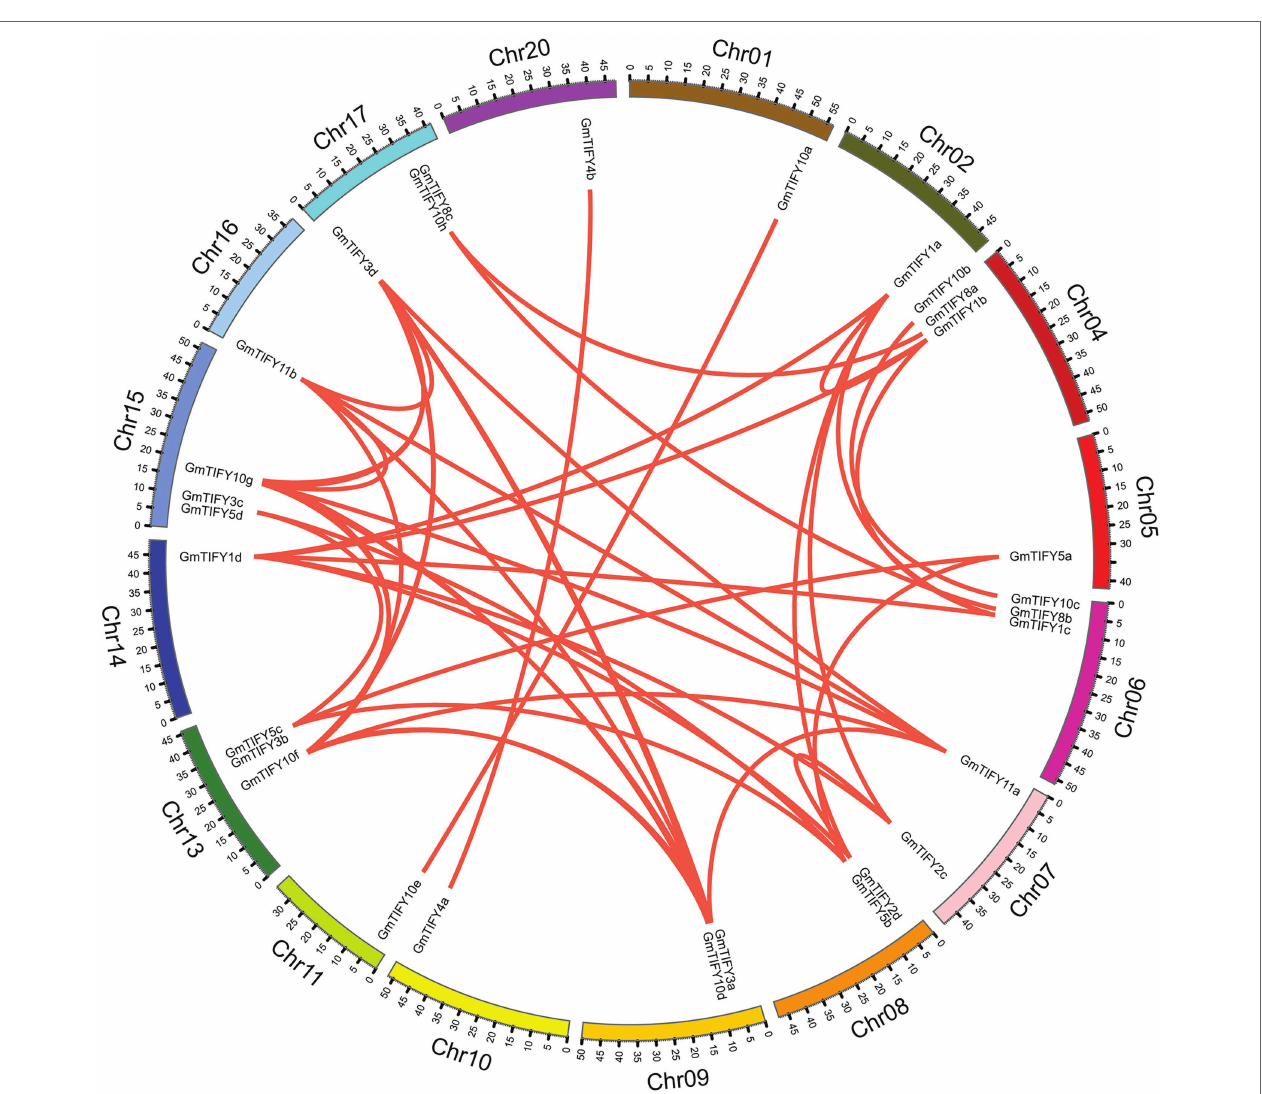
FIGURE 3 | Distribution of segmentally duplicated GmTIFY genes on soybean chromosomes. Red lines indicate duplicated GmTIFY gene